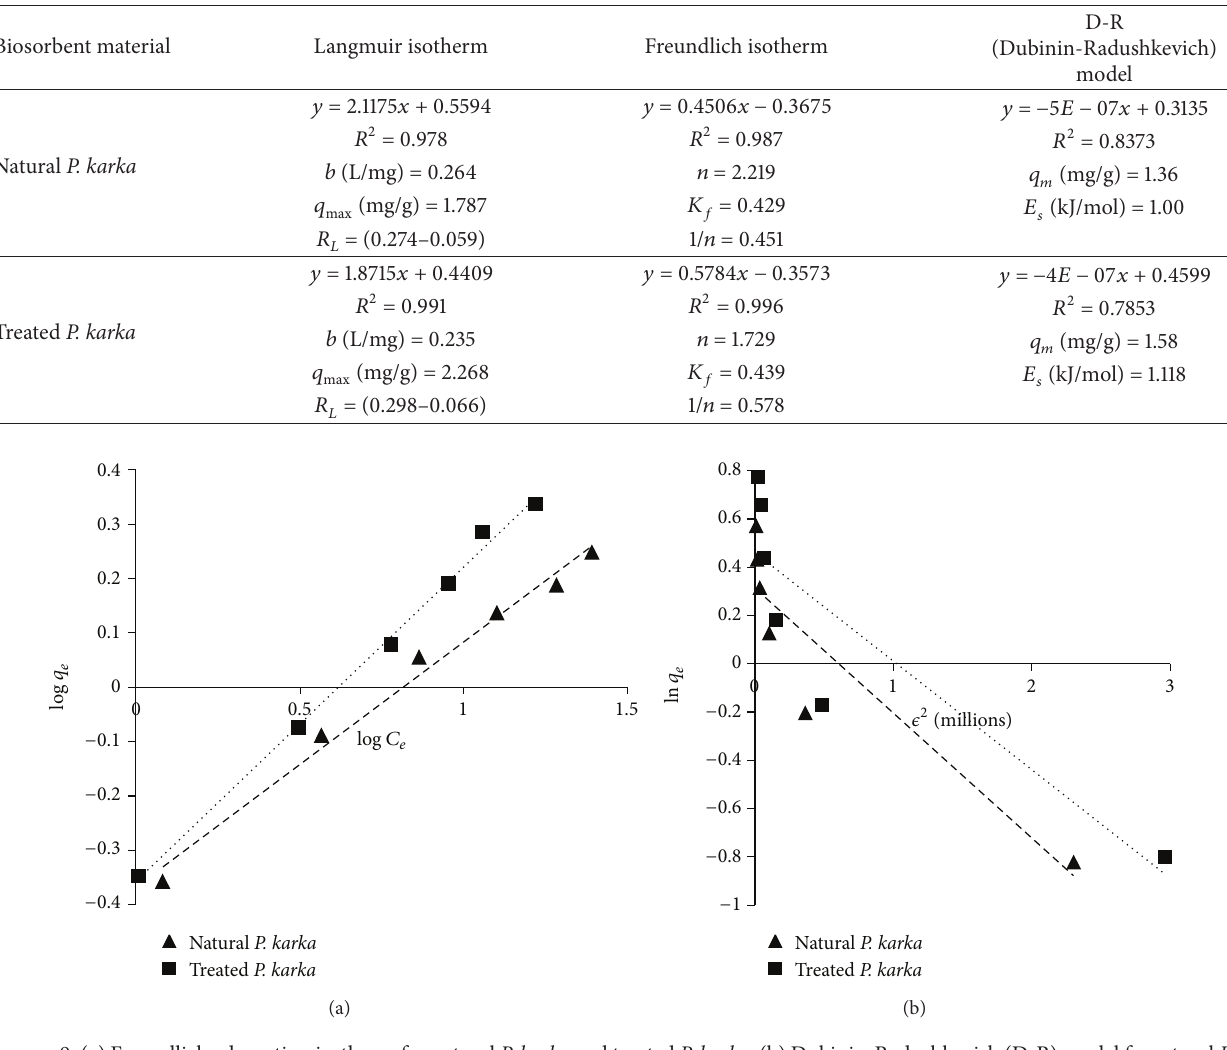
Figure 9: (a) Freundlich adsorption isotherm for natural P. karka and treated P. karka . (b) Dubinin-Radushkevish (D-R) model fornatural P. karka and treated P. karka (concentration = 10–60 mg/L, time = 50 and 40 minutes for natural P. karka and treated p. karka , resp., 𝑇 = 298 K, agitation speed = 150 and 100rpm natural P. karka and treated p. karka , resp., dose of biosorbent = 1g/100mL, and pH = 6 and 7 for natural P. karka and treated p. karka ,